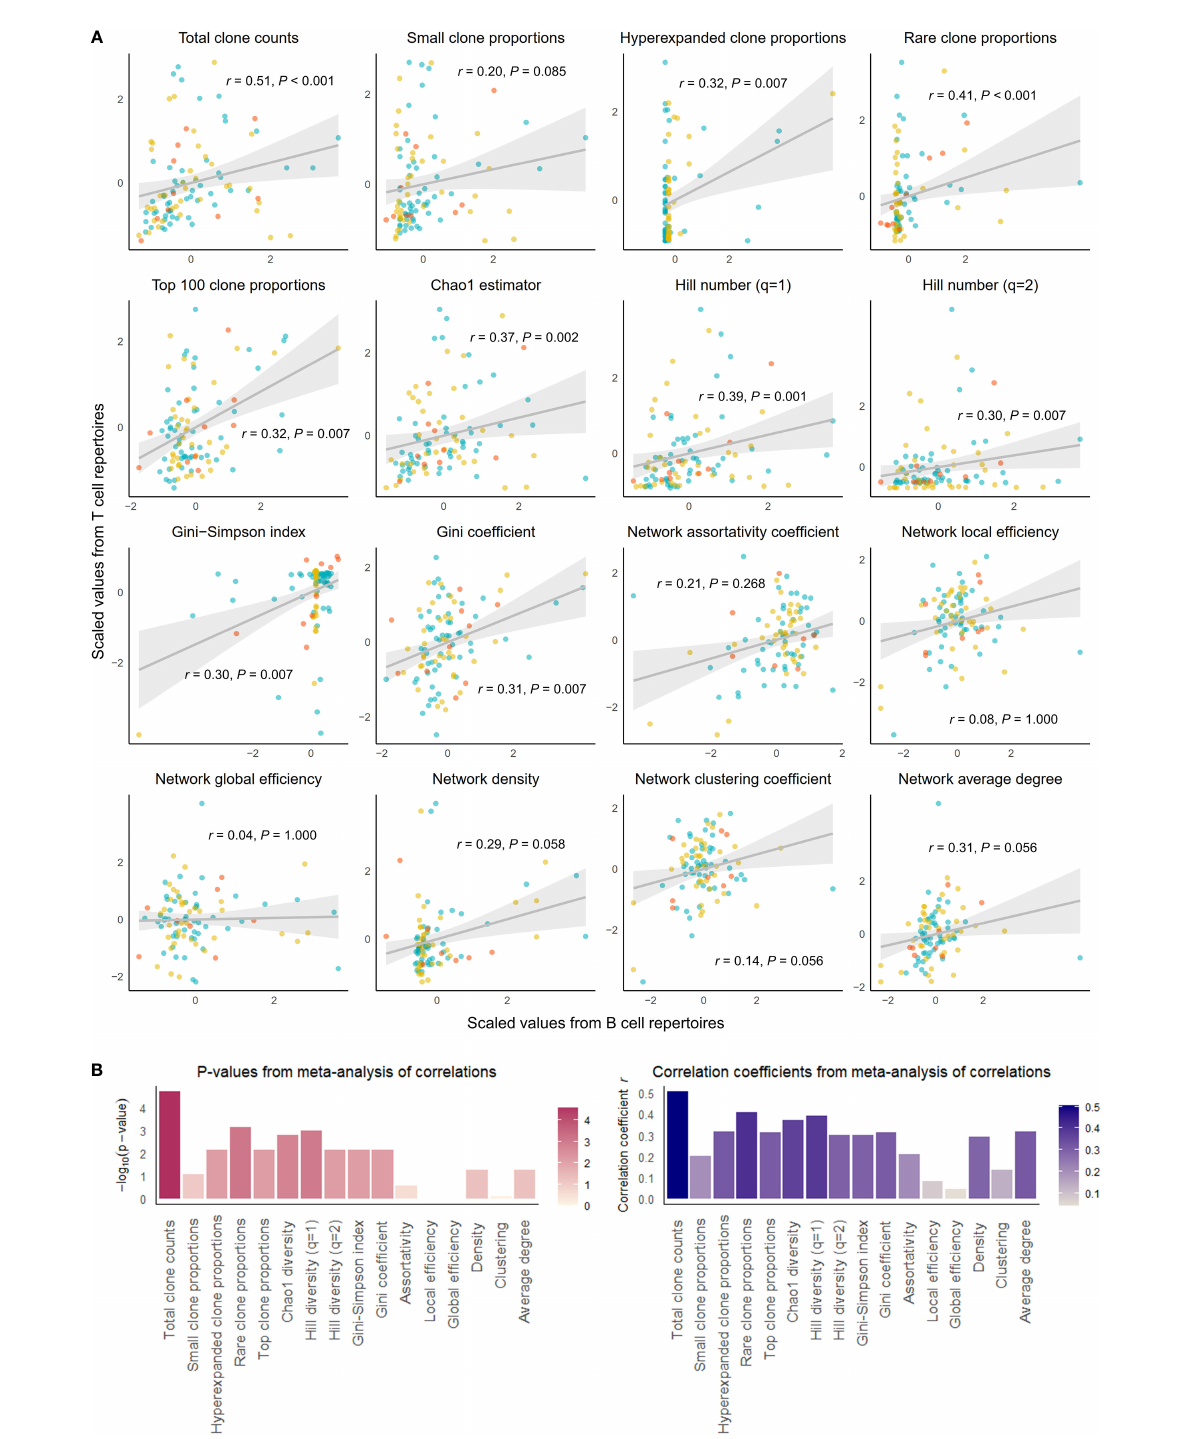
FIGURE 2 Correlation of select repertoire summary statistics between B and T cell repertoires of individuals with disease. (A) Scatterplot of scaled summary statistics for B and T cell repertoires of individuals with disease. Colors represent individuals from different studies. r and P values are derived from inverse variance-weighted fi xed-effects meta-analysis across all studies (B) Bar plots of P -values (left) and correlations coef fi cients r (right) from the meta-analysis of correlations for different summary